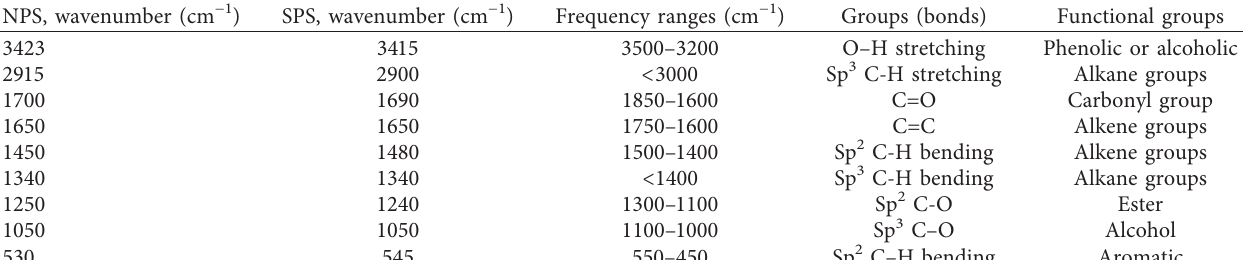
Table 1: FT-IR peaks of the functional groups in NPS and SPS.